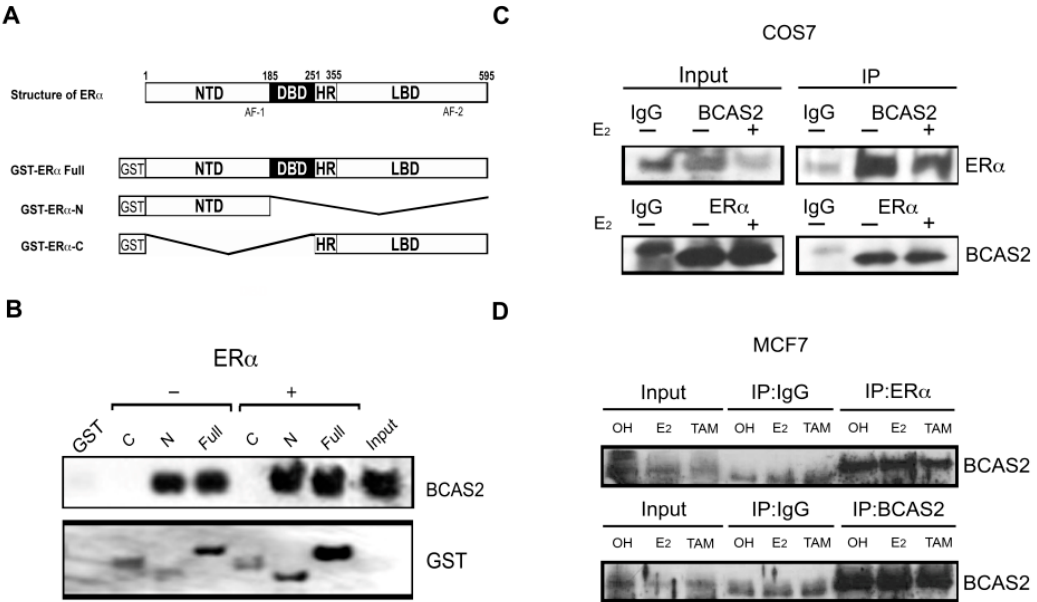
Figure 1. BCAS2 interacts with ER α in vivo and in vitro. ( A ) Structure of ER α and its N and C domains used for Glutathione sepharose affinity matrix assays. NTD, amino terminal domain; DBD, DNA binding domain; HR, hinge region; LBD, ligand binding domain. ( B ) GST pull-down assays of biotin labeled in vitro translated BCAS2 with GST alone, GST-ER α -Full (full-length aa 1-595), GST-ER α -N (aa 1-180) GST-ER α -C (aa 264-595). Western blot analysis was carried out using anti-biotin or anti-GST antibodies. Binding was assayed in the presence (+) or absence ( − ) of 100 nM E2. ( C ) Coimmunoprecipitation of ER α and BCAS2. COS7 cells were transfected with plasmids expressing ER α and BCAS2 in the presence (+) or absence ( − ) of 10 nM E2. Immunoprecipitation of whole cell protein extracts was carried out with antibodies against BCAS2 or ER α and IgG as negative control. Shown are immunoblots probed with antibodies against both proteins. ( D ) Coimmunoprecipitation assays in MCF7 cells in the presence of ethanol (OH), E 2 (10 nM) or TAM (100 nM) showing